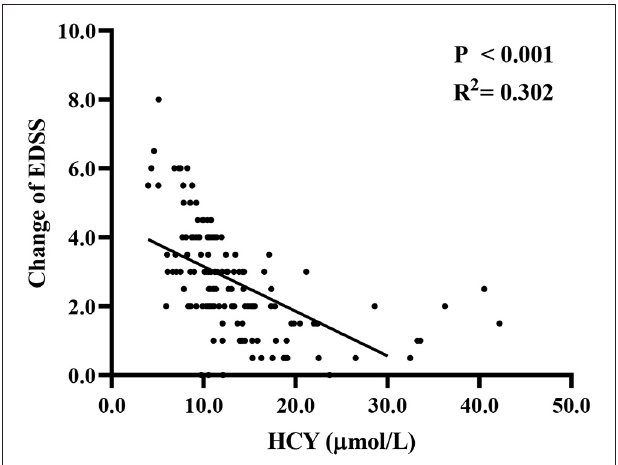
FIGURE 2 | The association of Hcy level with changes between final EDSS and initial EDSS. EDSS, expanded disability status scale; Hcy, homocysteine. TABLE 2 | Predictors of outcomes for NMOSD patients by univariate and multivariable logistic regression models. Factor Univariate analysis Multivariable analysis